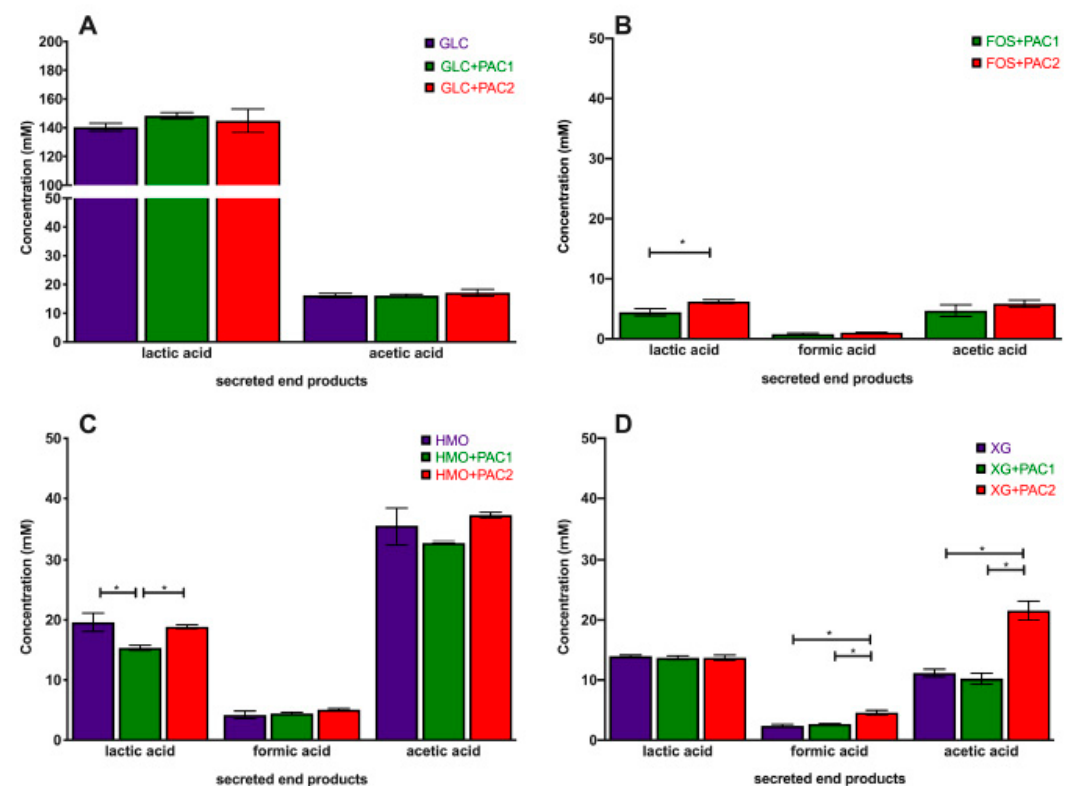
Figure 2. Lactobacillus plantarum secreted fermentative end-products while utilizing oligosaccharides and cranberry PACs. Absolute concentrations of lactic acid, acetic acid, and formic acid following the fermentation of glucose ( A ), fructooligosaccharides ( B ), human milk oligosaccharides ( C ), and xyloglucans ( D ). Averages from independent biological triplicates are depicted, and bars represent standard deviations of the mean. The values for organic acid production are expressed in millimolar absolute concentrations. Asterisks represent significant differences evaluated by two-way ANOVA and Tukey’s multiple comparisons test ( p < 0.05).